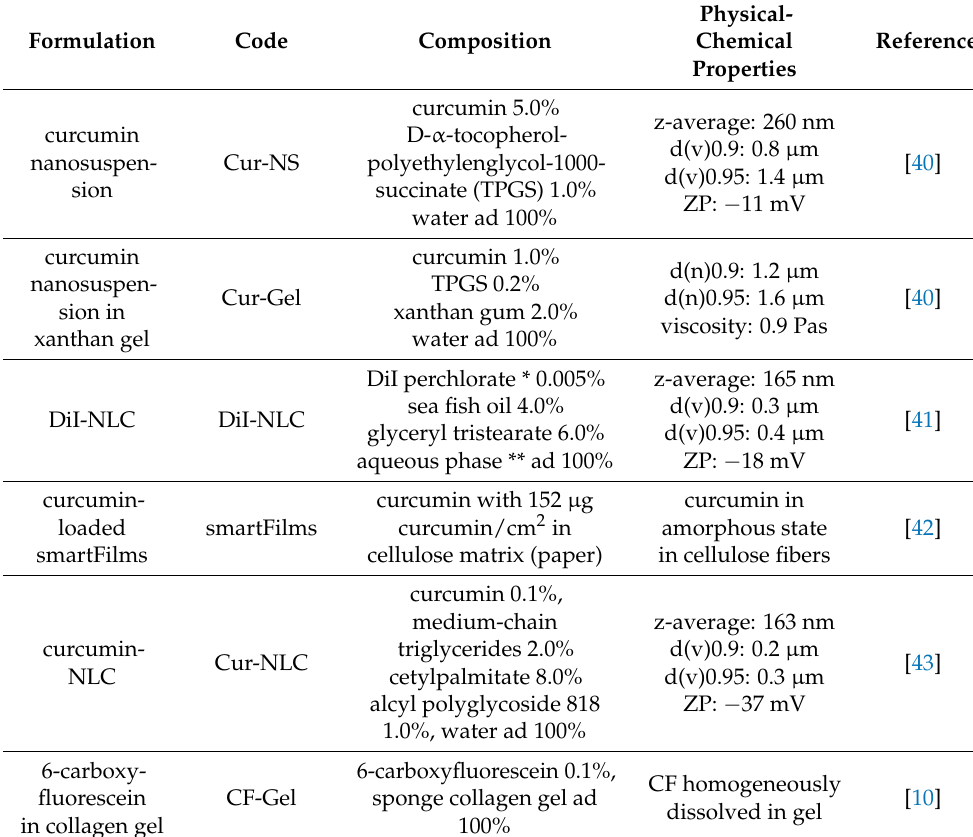
Table 1. Overview of the formulations tested, their compositions and physical-chemical properties during the test period of the study.